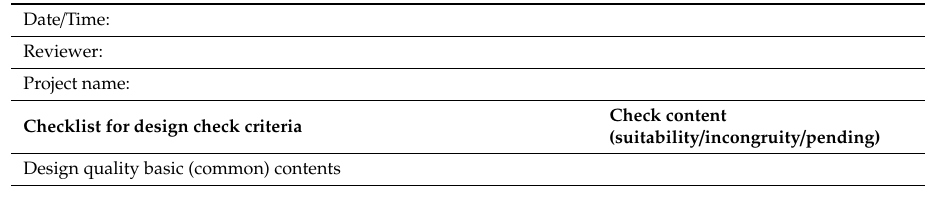
Table 7. Example of checklist for design check